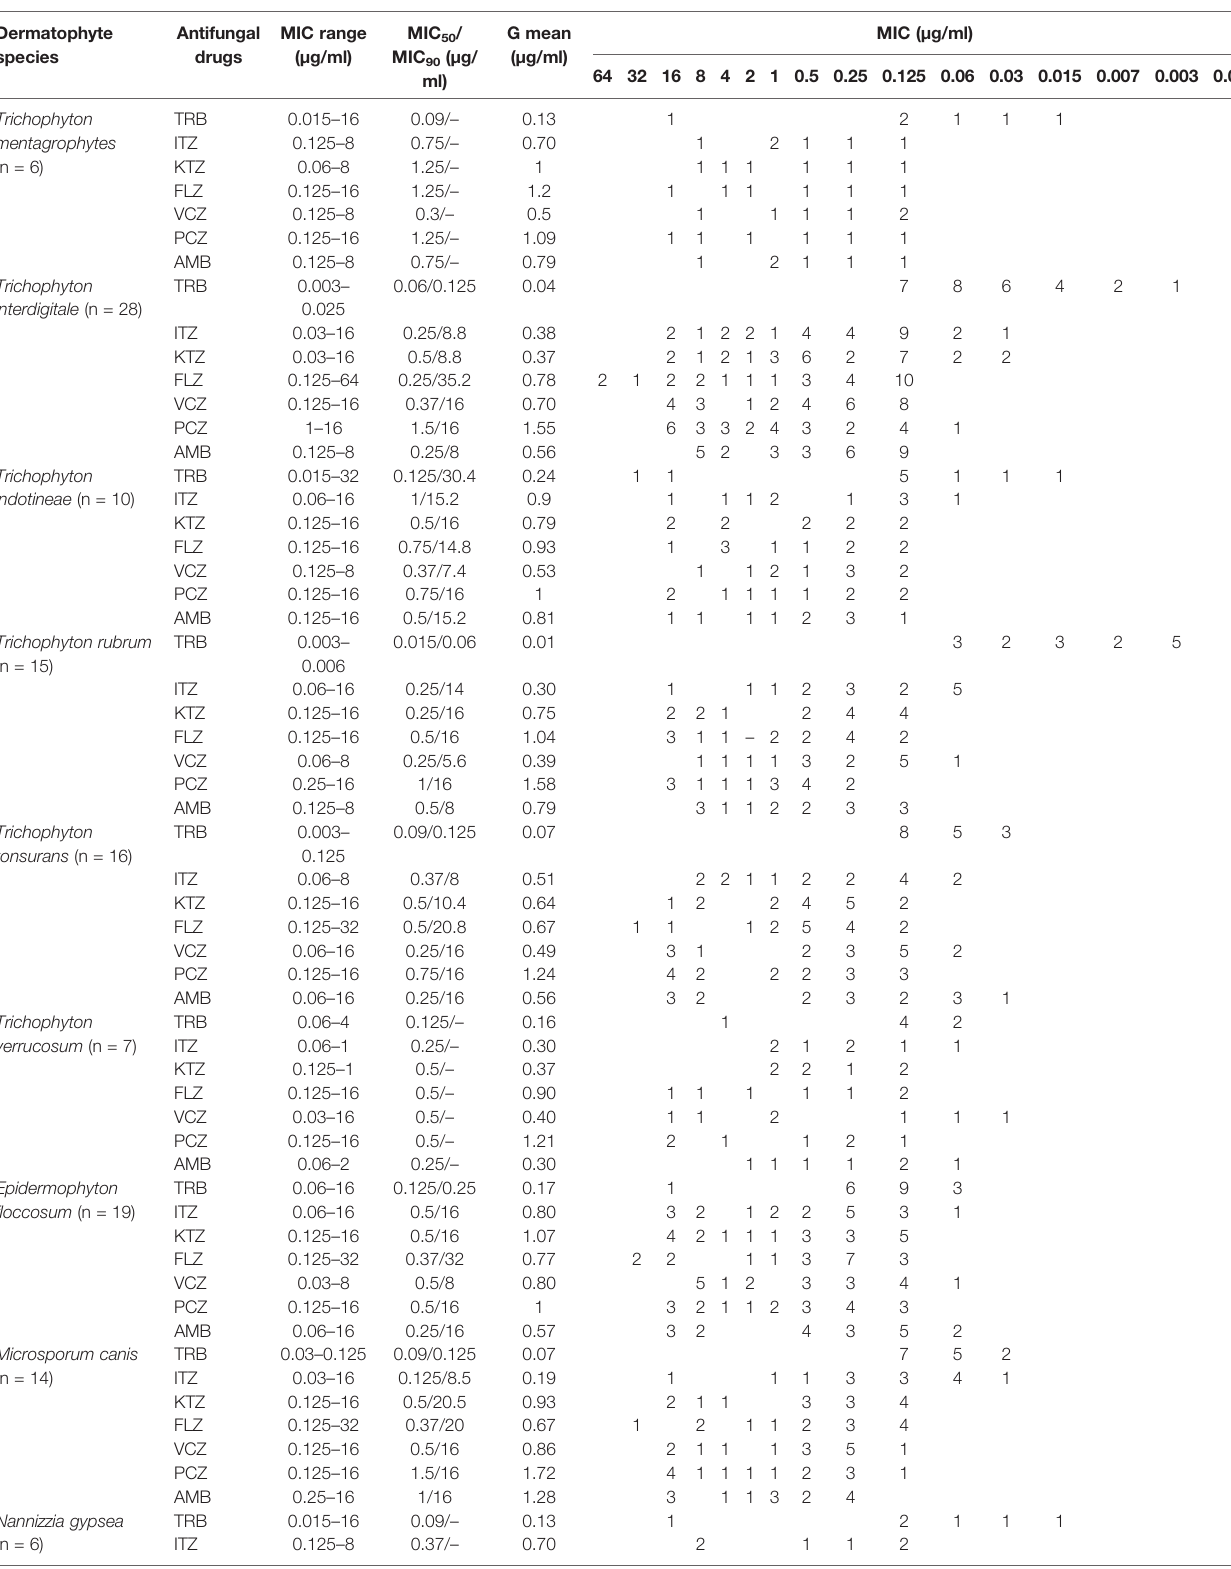
TABLE 3 | Antifungal susceptibility pro fi le of 123 dermatophyte strains to seven antifungal agents by broth microdilution method. Dermatophyte